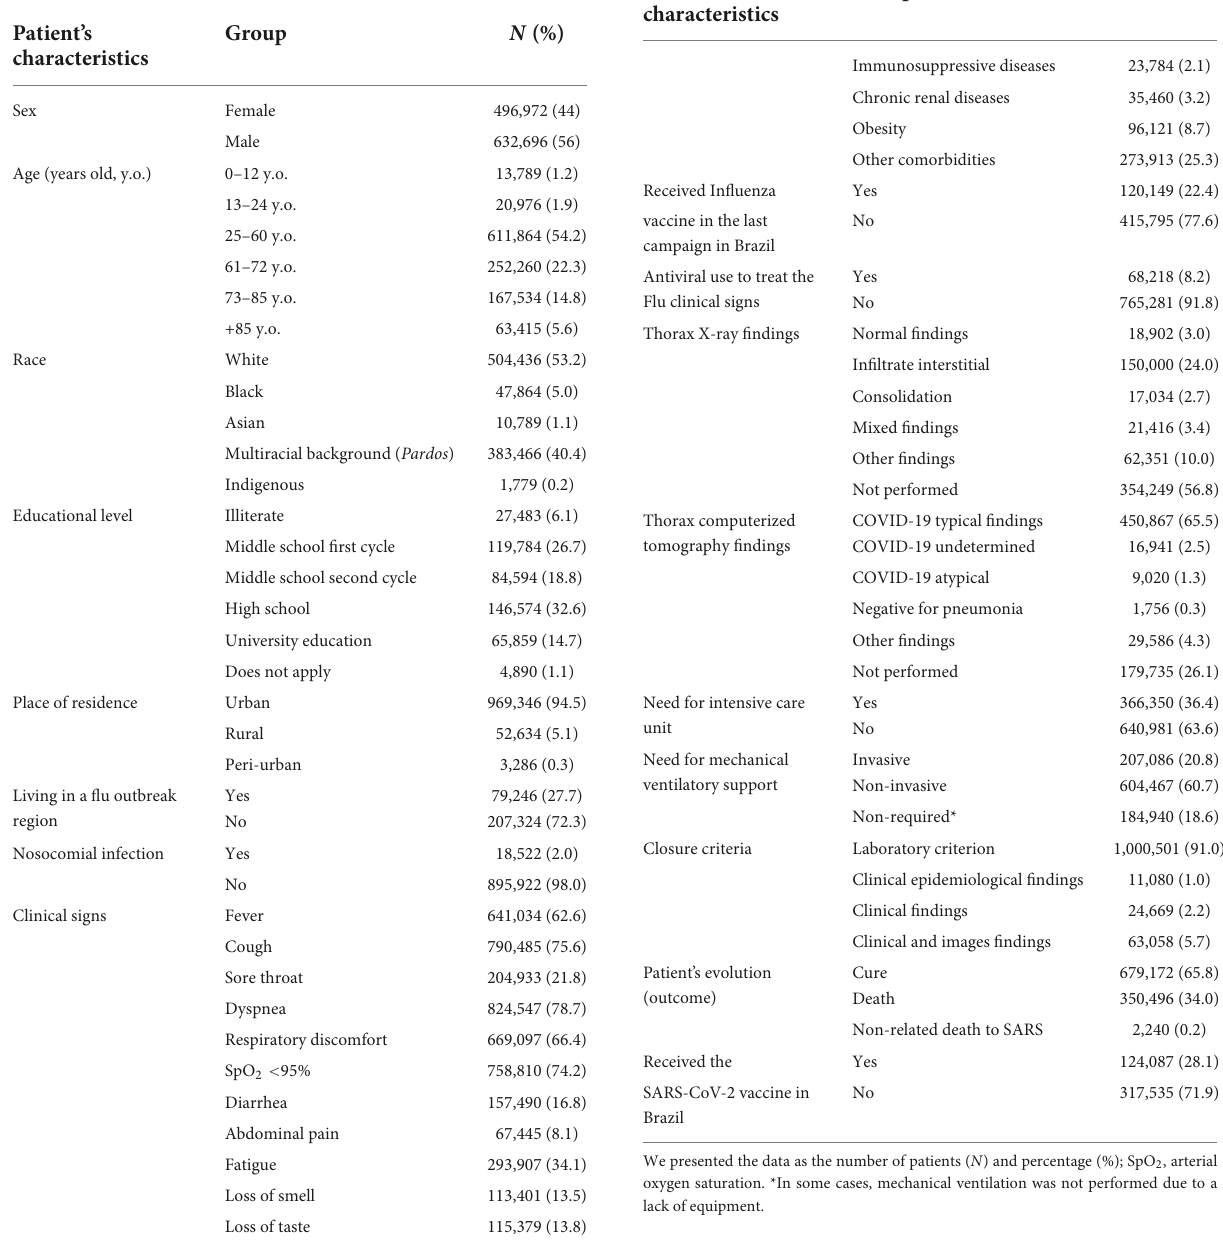
TABLE 2 Characterization of Brazilian hospitalized patients with severe acute respiratory syndrome (SARS) due to the coronavirus disease